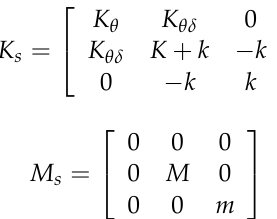
Figure 5. Representative model of elevated tank.